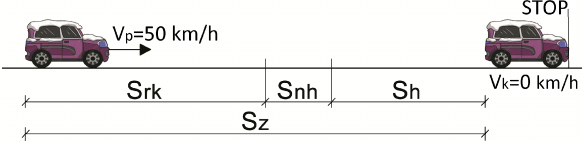
Figure 1: Graphic representation of the stopping distance of a car – three components